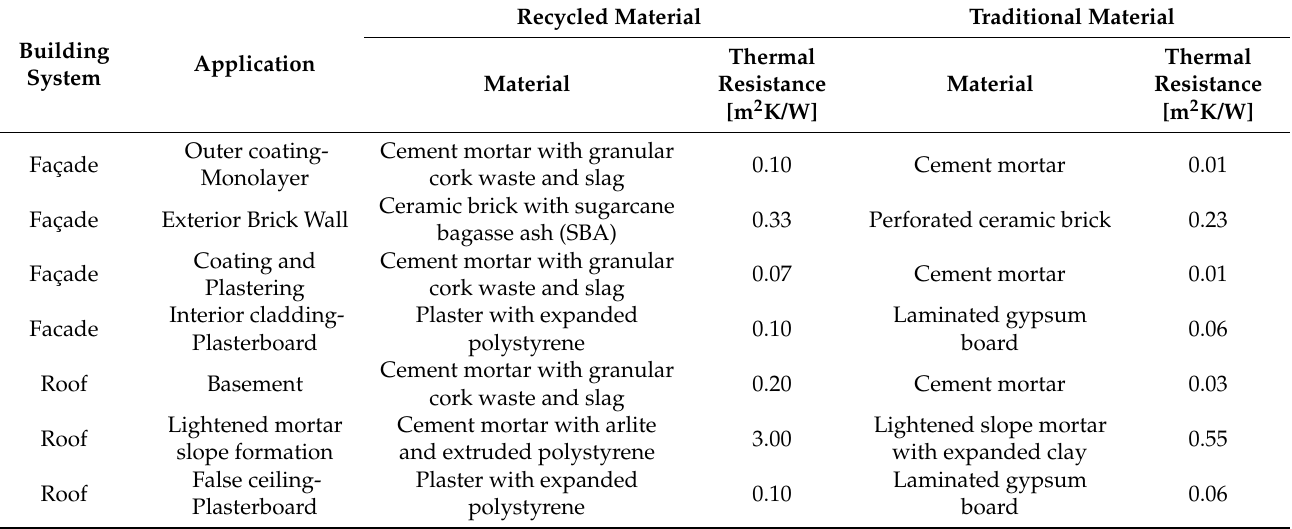
Table 5. Traditional materials replaced by recycled materials in the case studies